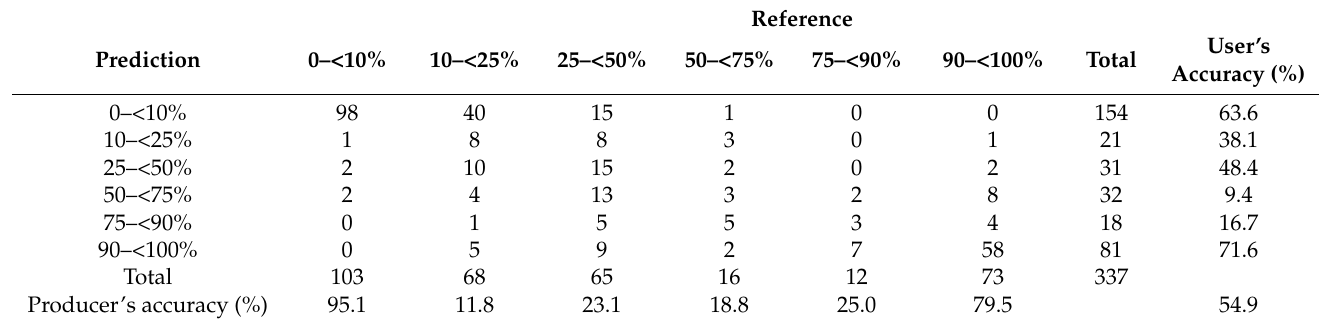
Table A20. Confusion matrix for current (Miller et al., 2009) model predicting EA canopy cover change with Landsat RdNBR with